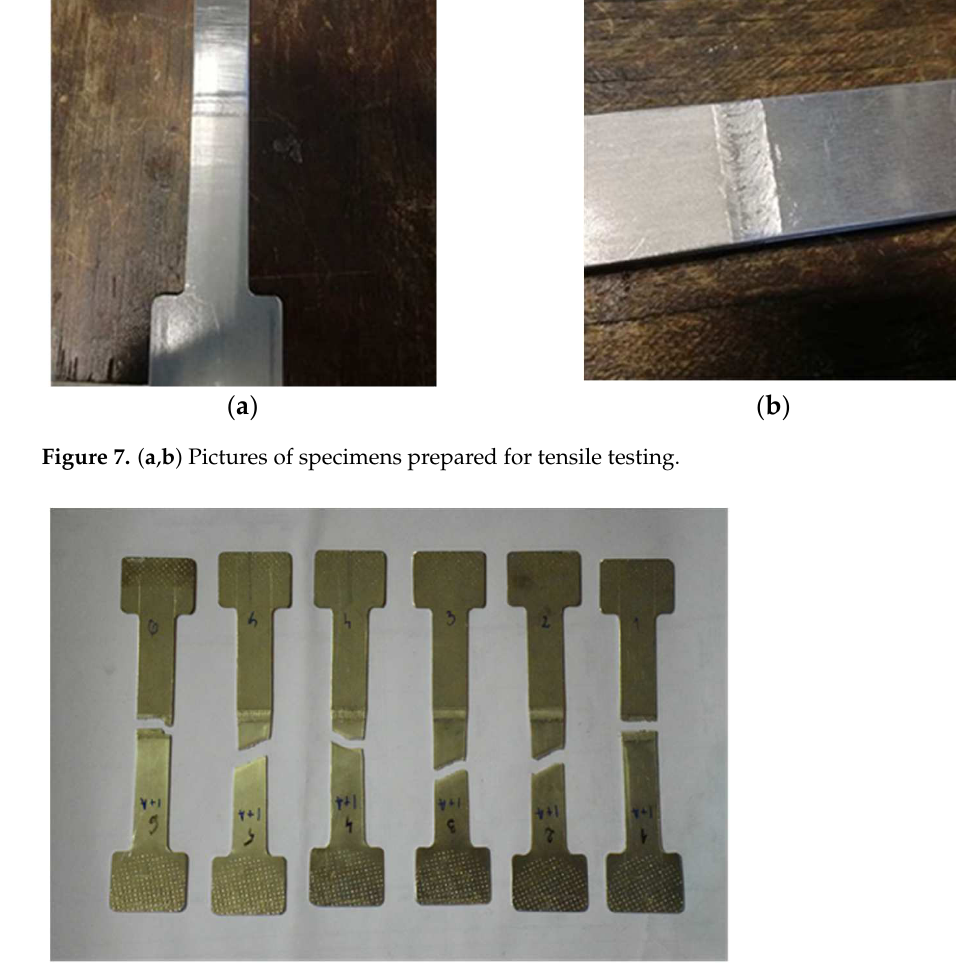
Figure 8. Pictures of the six specimens after the tensile test.